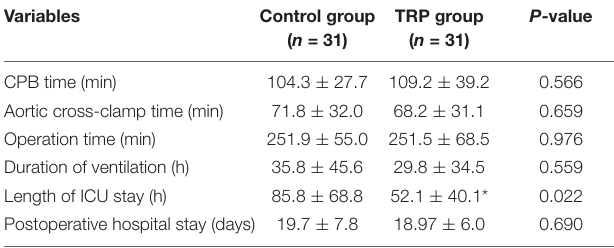
TABLE 2 | Patients’ perioperative